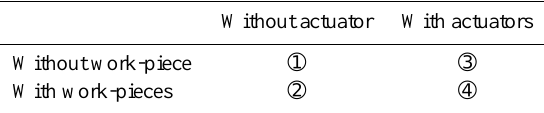
Table 1. Four Design Specifications of CM